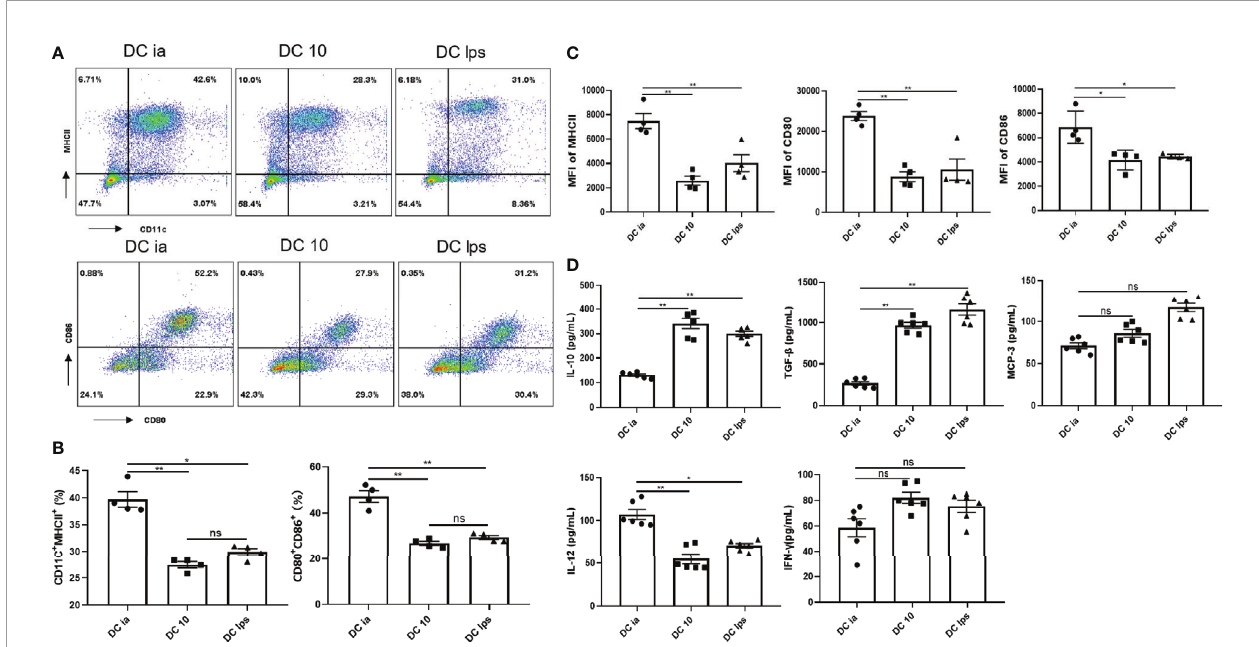
FIGURE 1 | Secretory capacity and costimulatory molecule expression of DCs. (A) The percentage of CD11c + MHCII + cells, and CD80 + CD86 + expression on CD11c + MHCII + cells determined by FCM. (B) Percentage of CD11c + MHCII + and CD11c + MHCII + CD80 + CD86 + cells determined by FCM. (C) MFI of MHCII, CD80 and CD86 determined by FCM. (D) The levels of IL-10, TGF- b , MCP-3, IL-12 and IFN- g secreted by DCia, DC10 and DClps were determined by ELISA. The columns and error bars represent the mean and standard error of the mean (SEM). (*P < 0.05, **P < 0.01, ns, no signi fi cant difference, ANOVA with Tukey ’ s post hoc analysis). Data are representative of 3 independent experiments with similar results (n=5 in each